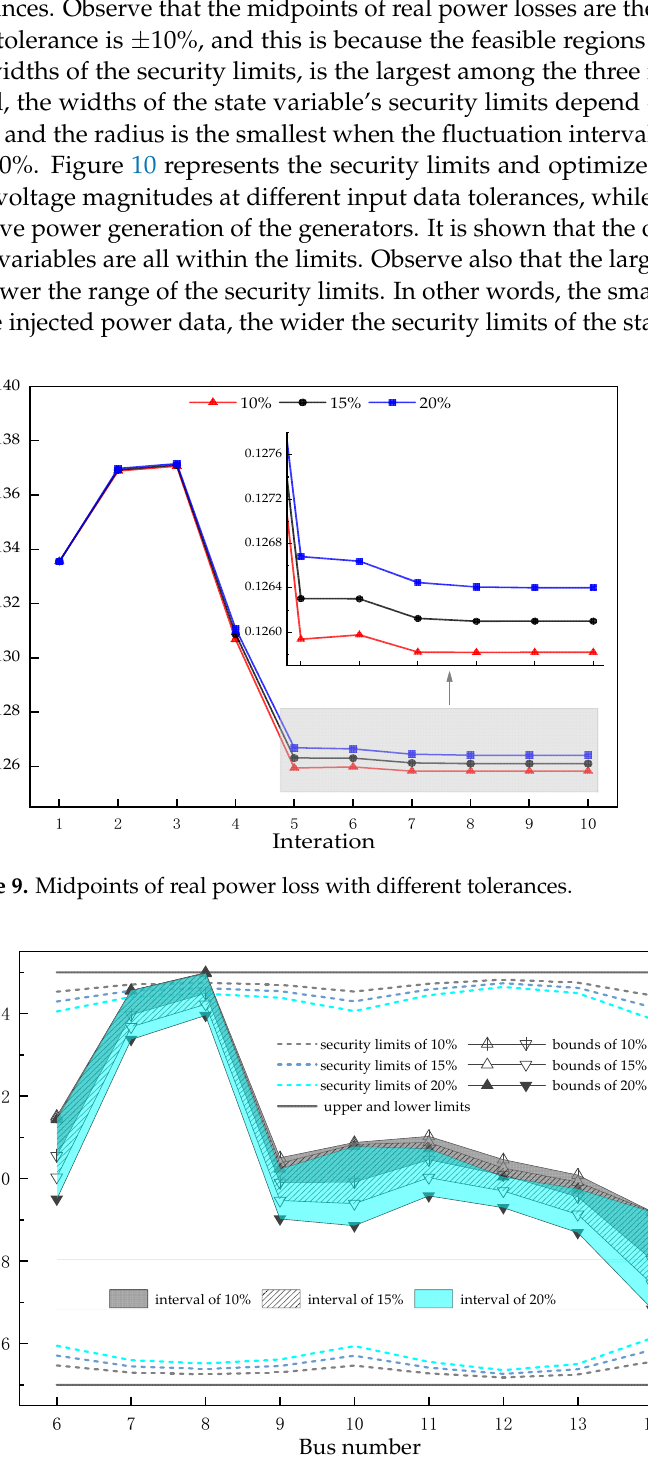
Slack generator Figure 8. IEEE 14-bus test system. Table 2. The capacitor and transformer parameters of the IEEE 14-bus test system.